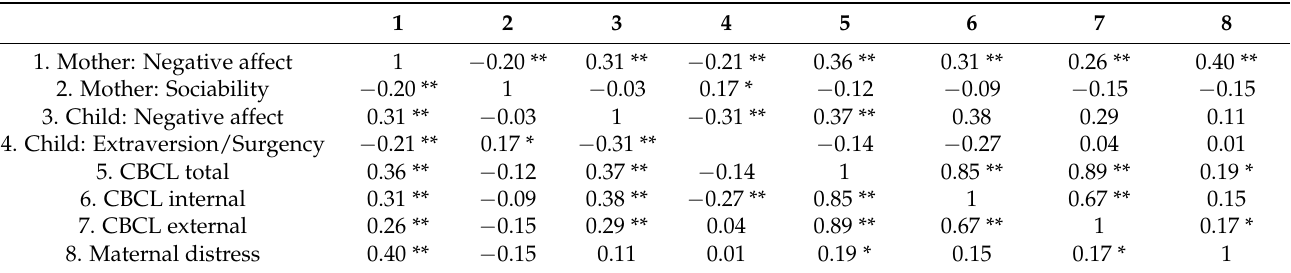
Table 3. Correlation coefficients between the dependent and independent study